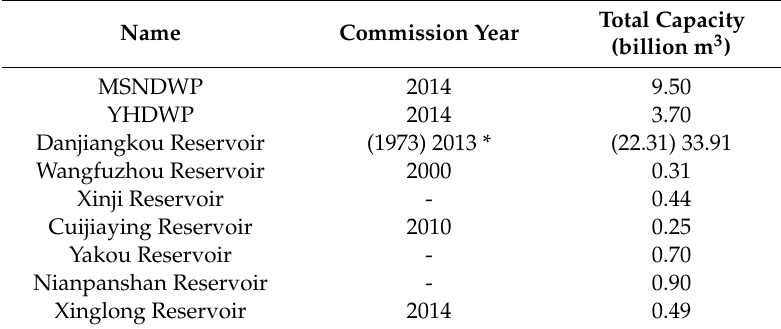
Table 1. Characteristics of the main projects in the Hanjiang